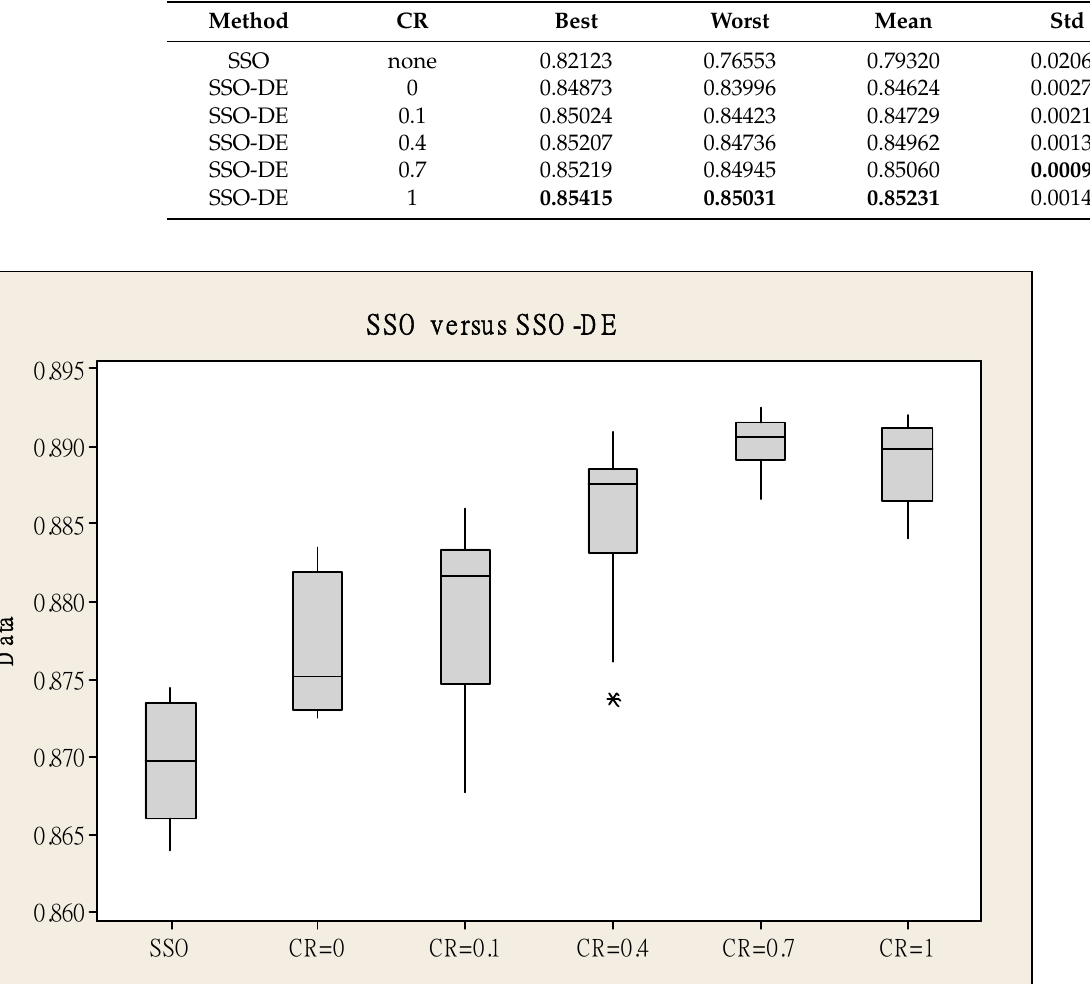
Figure 7. Box and whisker diagram of SSO and SSO-DE for spring (autumn). *: Outliers.